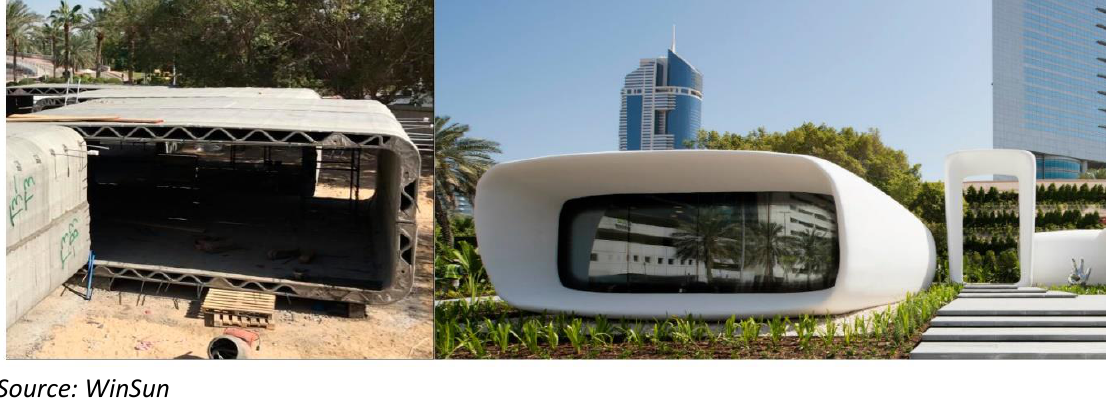
Figure 5: The world's first 3D-printed commercial building in Dubai